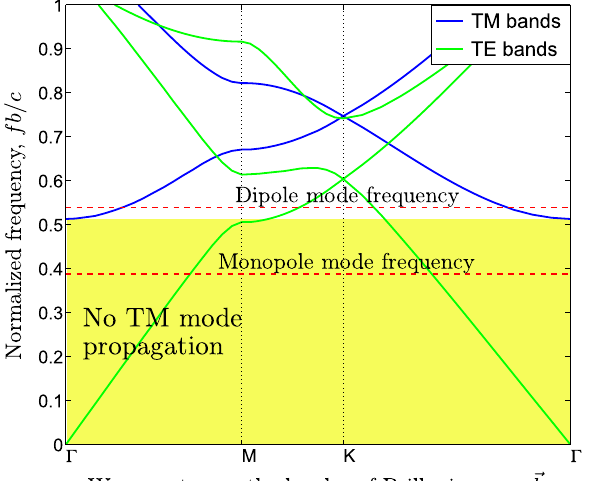
FIG. 1. Frequency of eigenmode solutions in an infinite photonic crystal as a function of the wave vector in the plane of the crystal. The crystal has a triangular lattice of metal rods with a ratio of the rod radius, a , to the spacing between the rods, b , equal to 0.15. Frequencies for the monopole and the dipole modes are shown with dashed straight lines in a resonator formed by a single removed